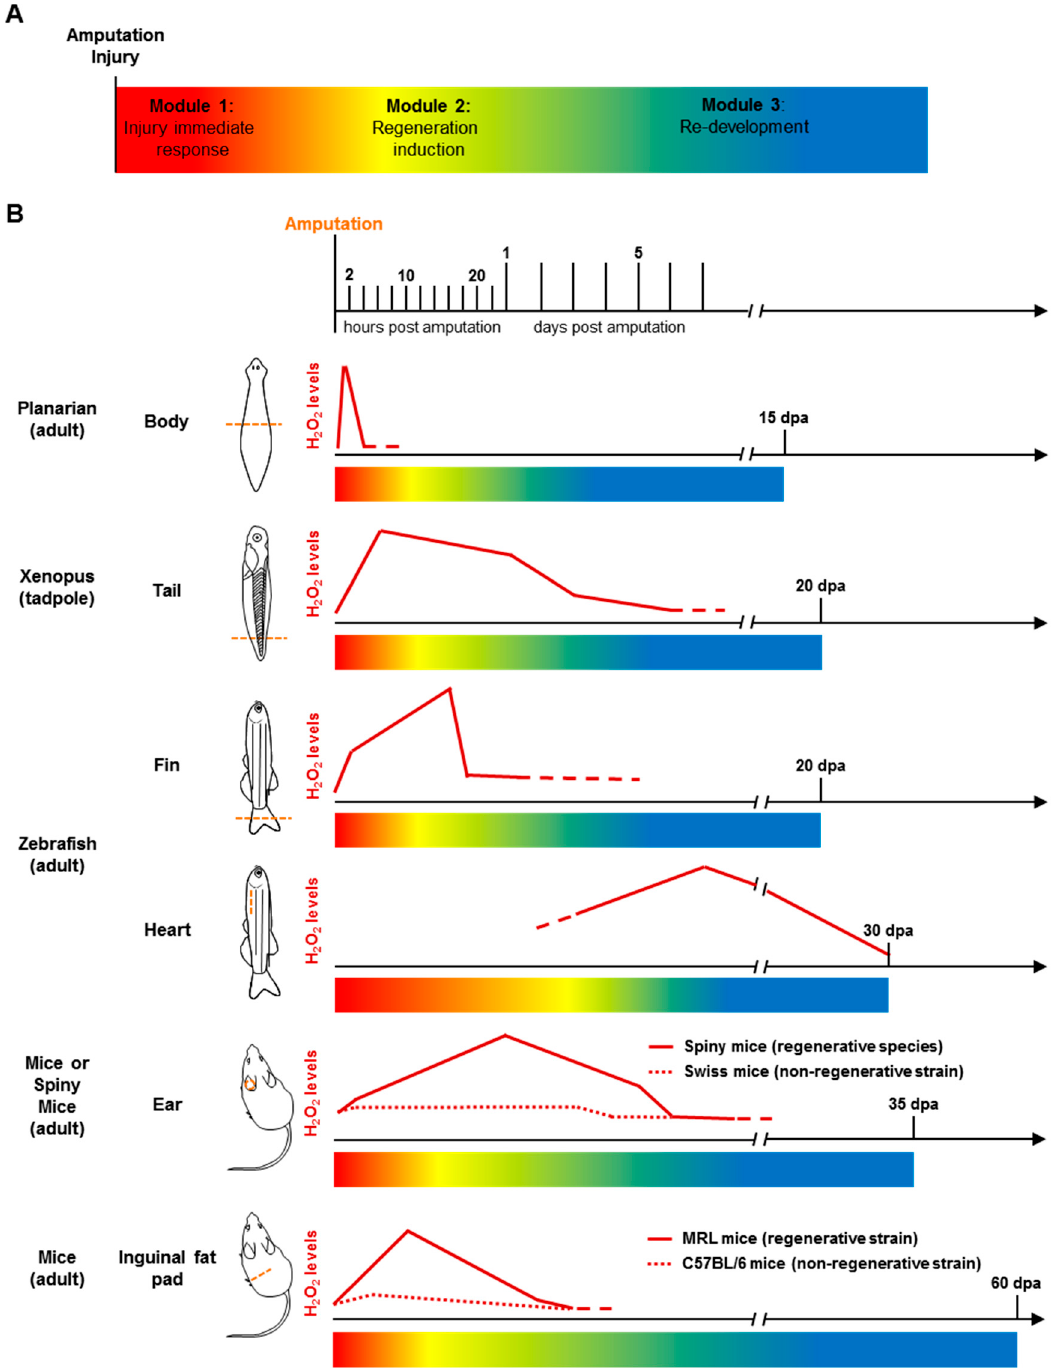
Figure 3. H 2 O 2 detection during metazoan regeneration. ( A ): regeneration is divided in three modules. ( B ): H 2 O 2 levels during regeneration in different models and organs. dpa: days post amputation. Adapted from [164–170].